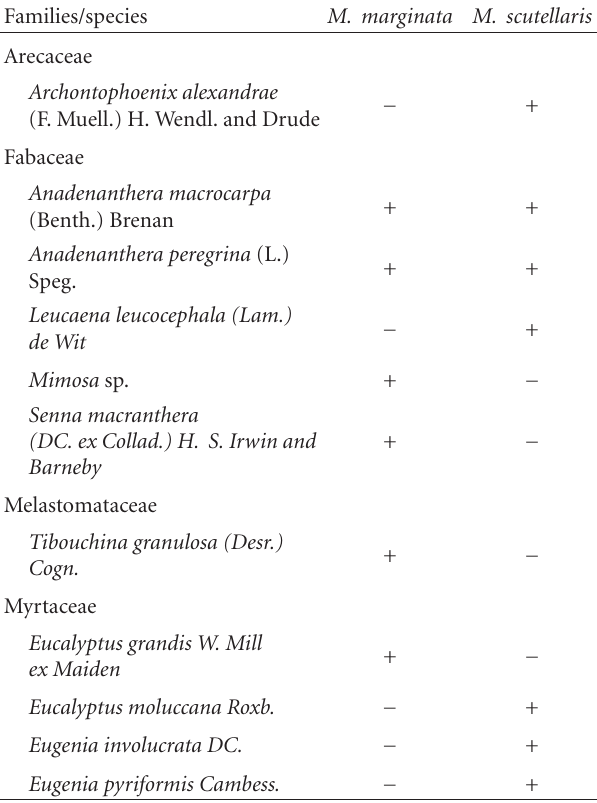
Table 3: Pollen types found in food pots of Melipona marginata and Melipona scutellaris